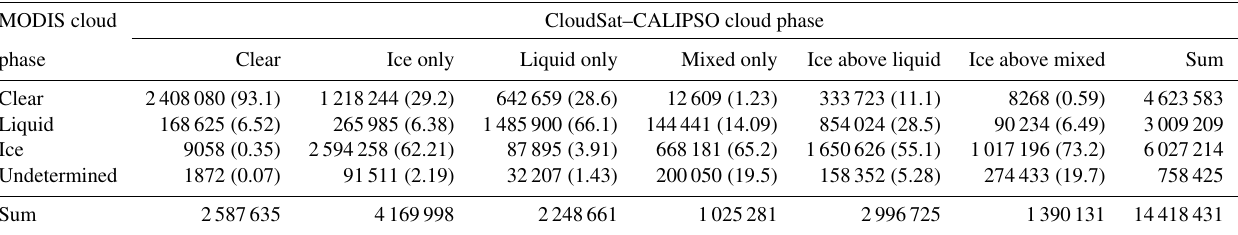
Table 2. Comparison of MODIS and CC cloud phase. Number in parentheses represents the percentage (%) of CC phase reported as MODIS cloud